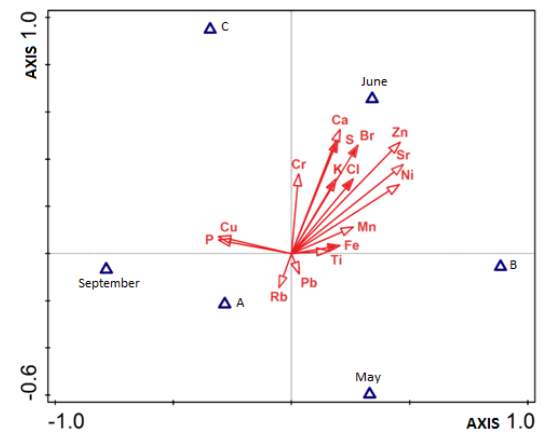
Figure 4: Discriminant analysis (CVA, Canonical Variate Analysis) of data on changes in the content of elements in the studied water biotopes and in the studied months (May, June, September). Elements, which significantly differentiate the test set indicates full returns vectors. It explain 70.5 % of the total variability of harvest.